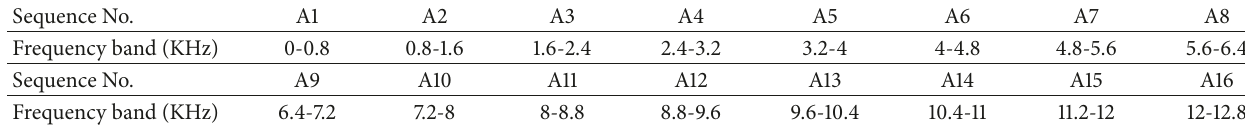
Table 4: Frequency bands of 4 levels of wavelet packet decompositions for the vibration signal. Sequence No.